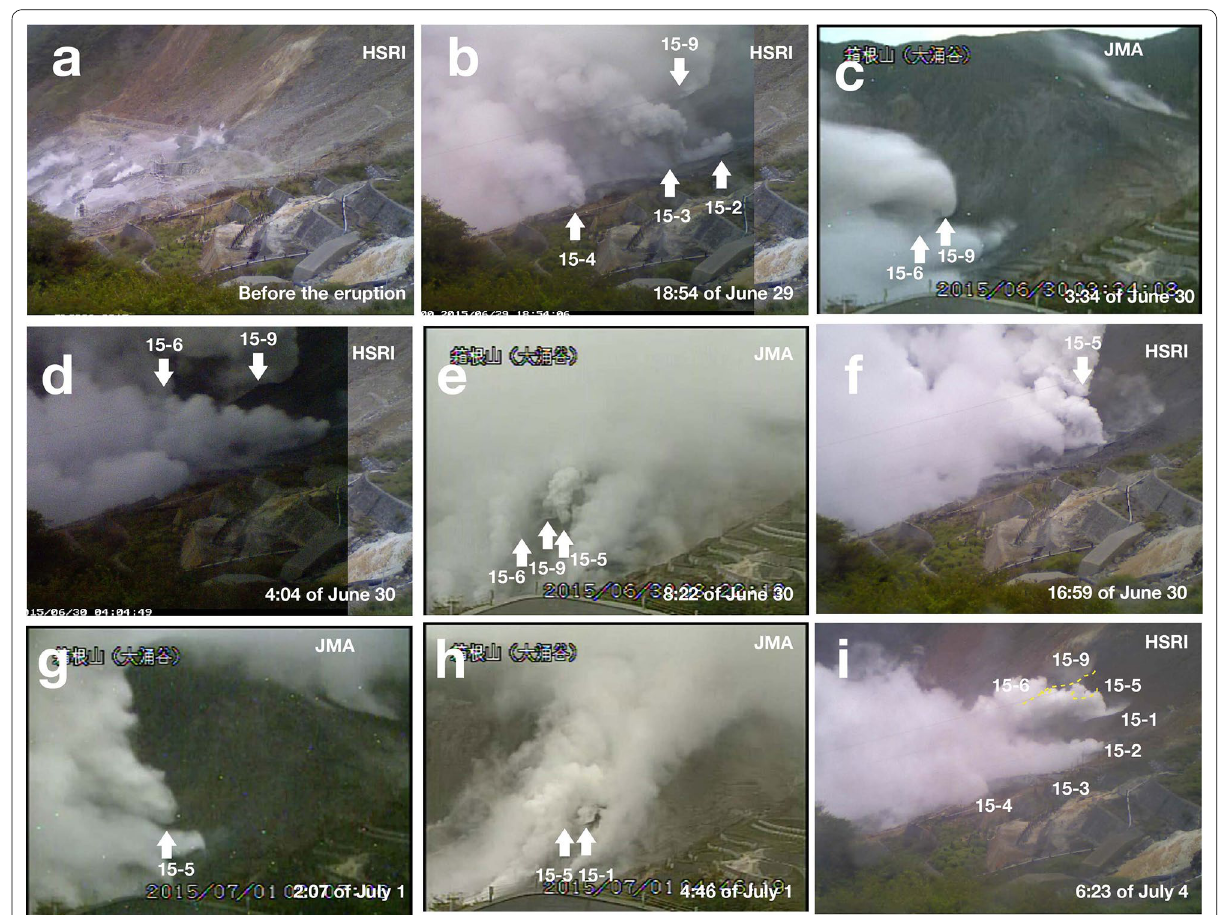
Fig. 13 Images of the eruption center and migration of the active crater during the 2015 eruption. Photographs were taken by a time-lapse camera (HSRI) and webcam (JMA). Locations of the cameras are shown in Fig. 2. a Area just before the 2015 eruption (darkened blending of images to